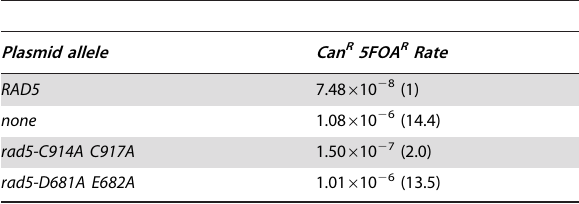
Table 3. Complementation of rad5 D in the yel072w::CAN1/ URA3 assay.